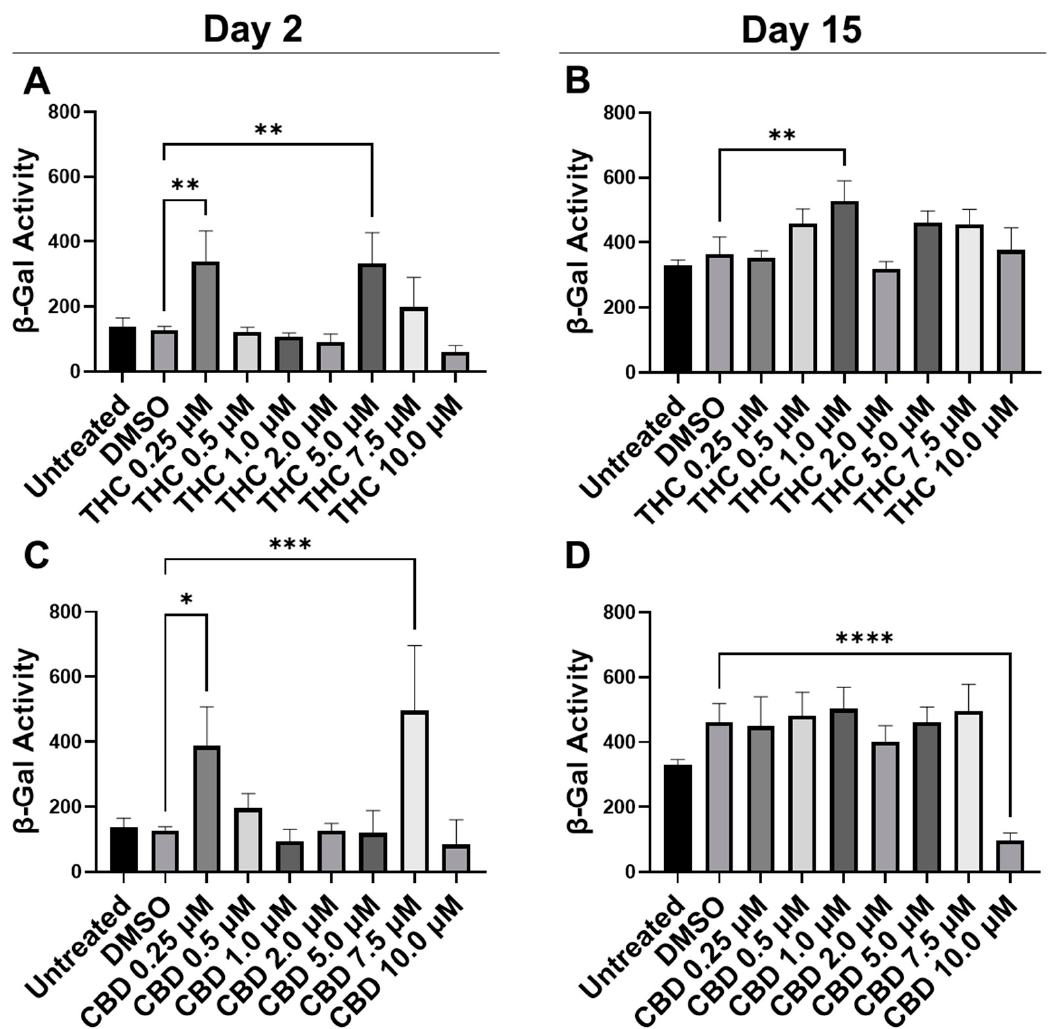
Figure 1. β -Gal activity in CCD-1064Sk human dermal fibroblasts (PDL 48) exposed to different concentrations of THC and CBD. ( A ) β -Gal activity after day 2 of THC exposure. ( B ) β -Gal activity after 15 days of THC exposure. ( C ) β -Gal activity after day 2 of CBD exposure. ( D ) β -Gal activity after 15 days of CBD exposure. Data were analyzed with an ANOVA test followed by a Dunnett’s post-hoc multiple comparison test compared to the DMSO vehicle. Bars represent mean ± SEM, n = 3. Significance is indicated using the following scale: * p < 0.05, ** p < 0.01, *** p < 0.001, **** p < 0.0001. CBD, cannabidiol; DMSO, dimethyl sulfoxide (vehicle); THC, delta-9-tetrahydrocannabinol.